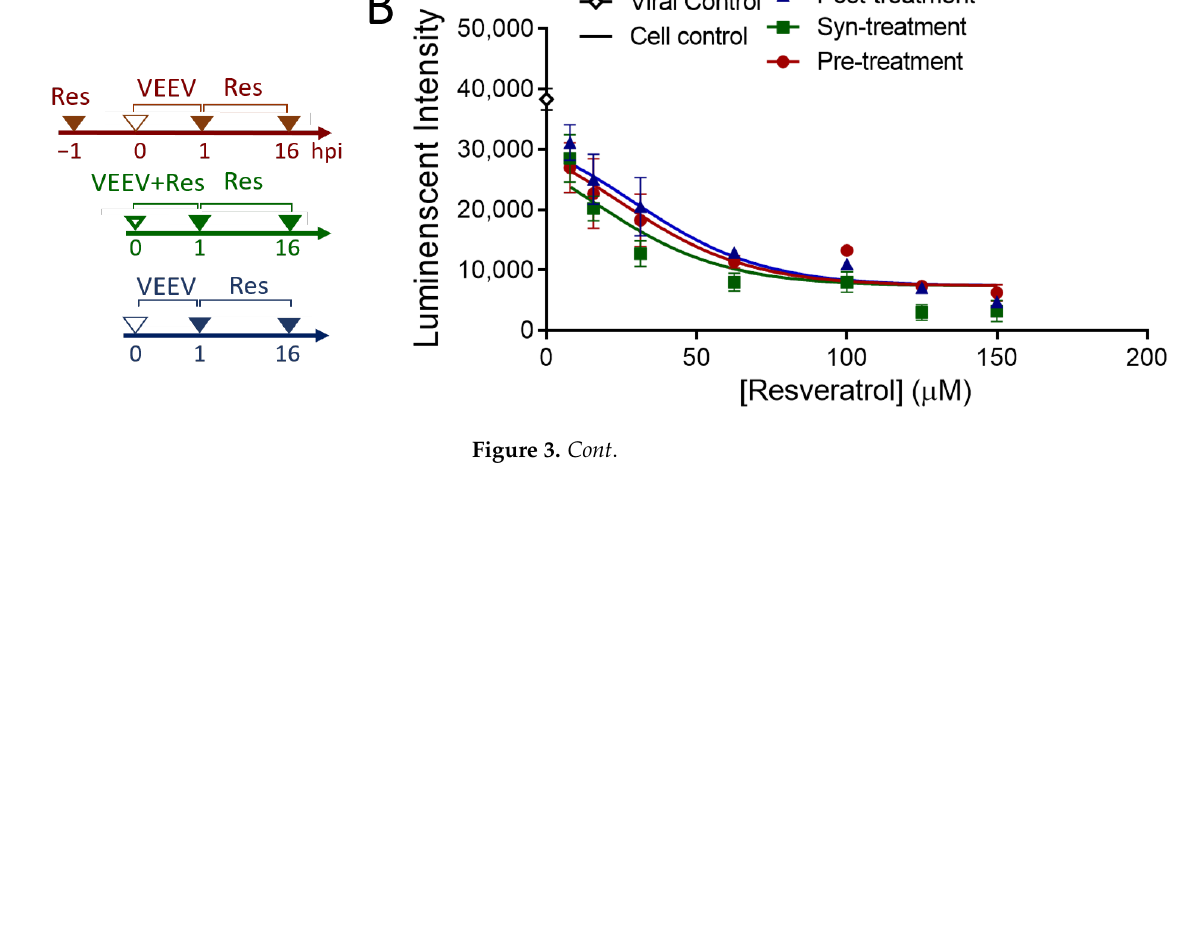
Figure 3. Time of addition of resveratrol marginally changed is antiviral effectiveness. ( A , C ) Schematic diagrams illustrat- ing the experimental design for the time-of-addition experiments. ( B ) Luciferase activity and ( D ) viral RNA of VEEV- TC83luc at an MOI of 0.1 corresponding to the experimental designs were determined by BrightGlo ® assays and qPCR, respectively, at 16 h.p.i. ( E ) Apoptotic signaling activity of caspase-3 and caspase-7 in VEEV-infected Vero cells (MOI = 0.1) were measured with Promega’s Caspase-3/7-Glo ® assays at 16 h.p.i. *** p < 0.001; **** p < 0.0001 by one-way ANOVA. Data are represented as means ± S.E.M. VC, viral control.